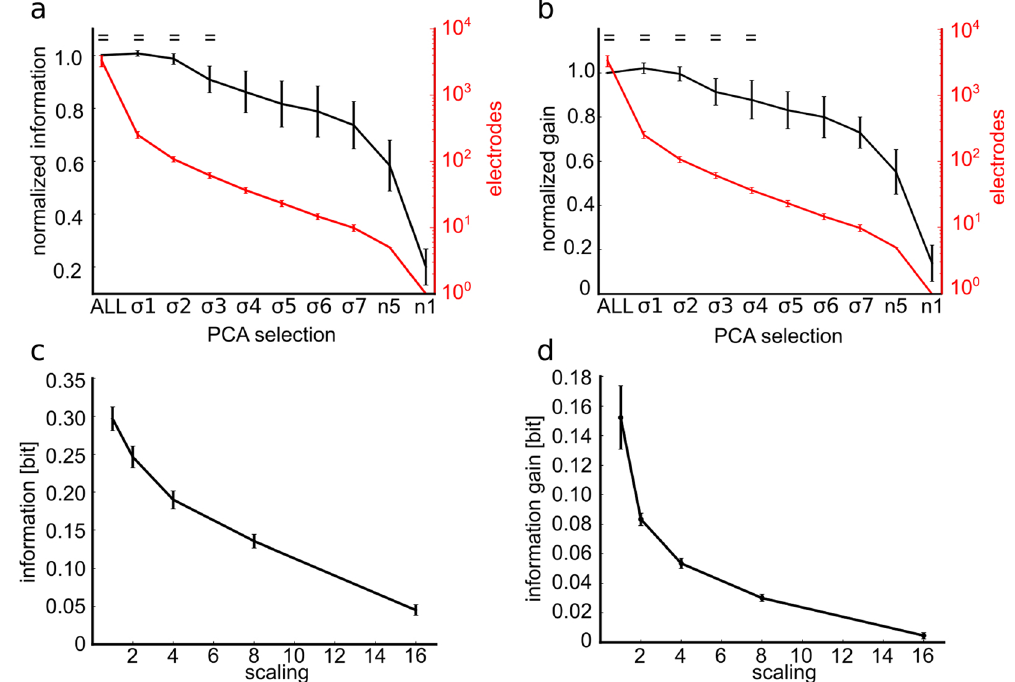
Figure 7. The information and information gain are carried by a subset of electrodes. For each experiment and PC, we selected subgroups of electrodes with PC weight (i.e. eigenvector values) higher than 1 to 7 standard deviations ( σ 1 to σ 7) from the mean PC. We also selected electrodes with the highest (n1) and highest five (n5) PC weights. For any selection, the information and the information gain are averaged across PCs and experiments (n = 4) and the corresponding means and SEM are reported. ( a ) The mean information of the selected electrodes is comparable to the information of the entire electrode array (ALL) up to σ 3, that corresponds to ~61 selected electrodes (F(9, 390) = 26.4, p = 10 − 35 ). The symbol = marks the data group that has similar means (Tukey’s HSD, p < 0.05), see Supplementary Information. ( b ) The mean information gain of the selected electrodes is comparable to the entire set of electrodes (ALL) up to σ 4, that corresponds to ~37 electrodes (F(9, 390) = 20.9, p = 10 − 29 ). Stars indicate no significantly different means respect to ALL (one-way between subject ANOVA followed by Tukey’s HSD multiple comparison test). The symbol = marks the data group that has similar means (Tukey’s HSD, p < 0.05), see Supplementary Information. ( c ) The information decreases steeply with the downscaling of the number of recording electrodes (i.e. the scaling factors 2, 4, 8 and 16 correspond to down-sampled arrays of size 32 × 32, 16 × 16, 8 × 8 and 4 × 4, respectively). ( d ) The information gain decreases even more steeply and decays almost to half of its value with a downscaling of 2. For each scaling factor the information and the information gain are computed for different samplings of the available 64 × 64 electrodes. The mean and SEM over the different samplings are